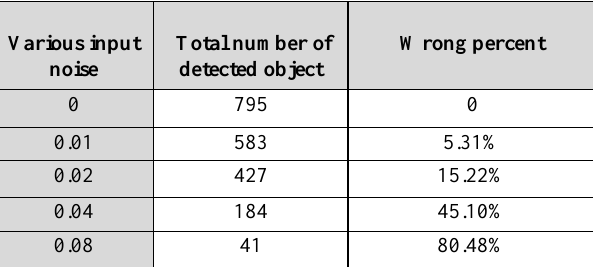
Table 2. Result of vehicle detection based on various input